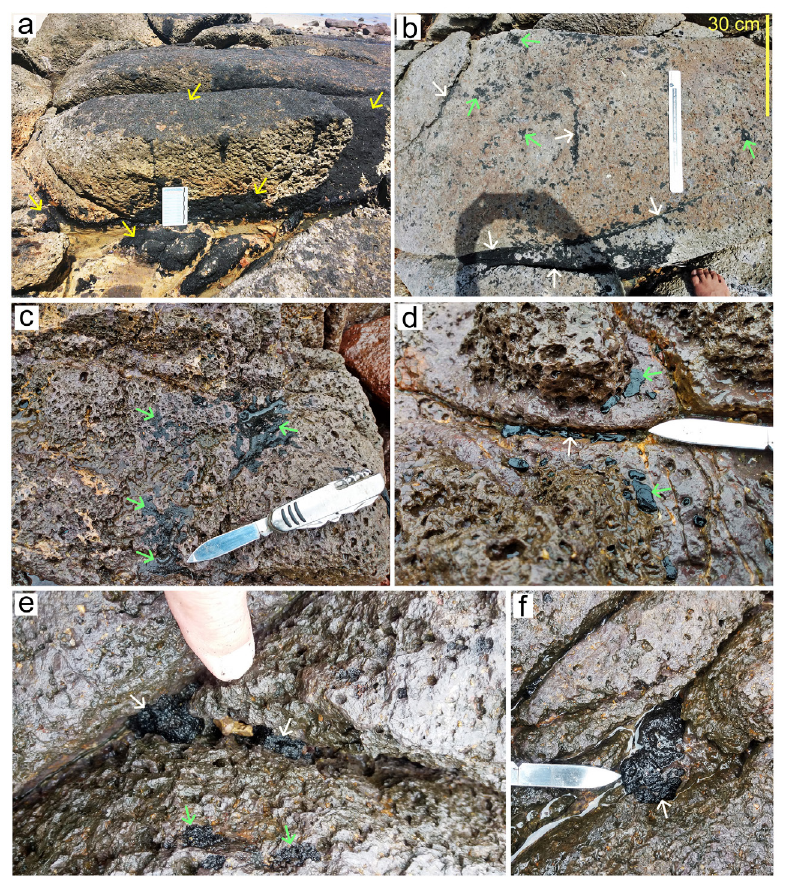
Figure 7. Tar residues in the trachyte rocks of Itapuama Beach. a) Oil residues adhered to the surface of the rocks and trapped within the joints and vesicles in the backshore in December 2019. b) Rock surfaces in the upper part of the backshore. c) Tar residues trapped in vesicles on a subvertical surface. d) Horizontal surface with tar residue. 7e and 7f) Tar residue trapped in rock joints. Photos c to f were taken in January 2021. White arrows - tar residue encrusted in fractures and joints, green arrows - tar residues encrusted in rock vesicles. The surfaces are wet due to rain. The seawater reaches these areas only during high spring